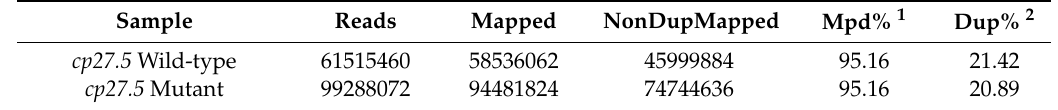
Table 1. Mapping statistics of RNA-Seq